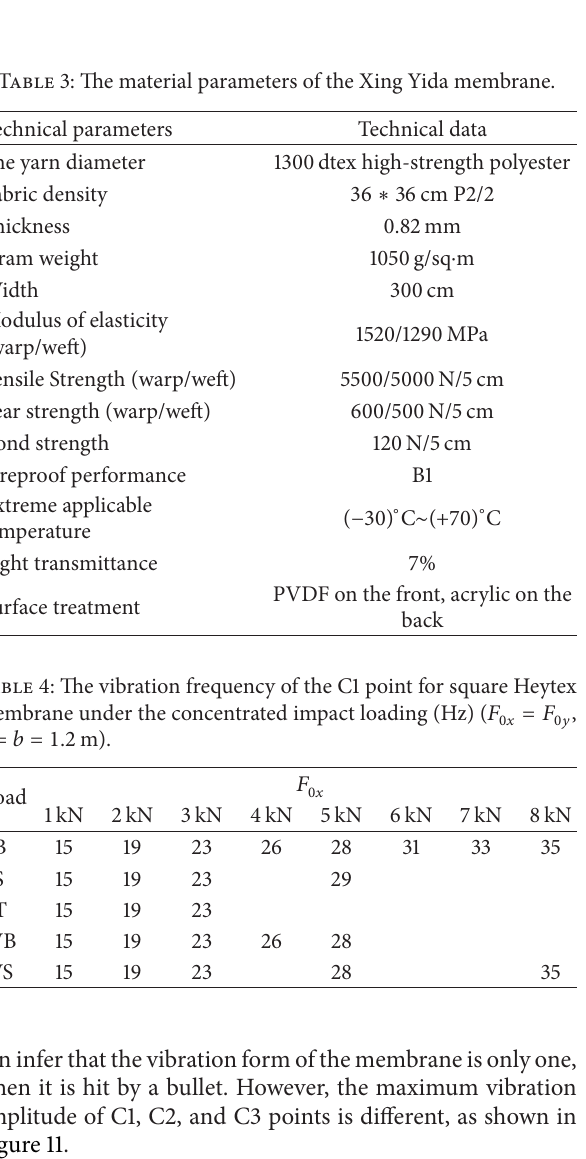
Figure 4: The experimental fabric membranes.